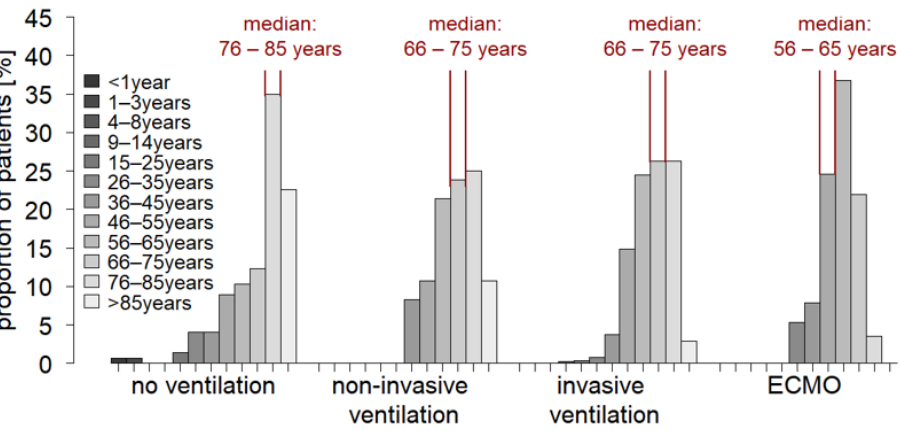
Figure 2. Distribution of age in COVID-19 patients in intensive care grouped by ventilation therapy received (total cohort, n = 840).